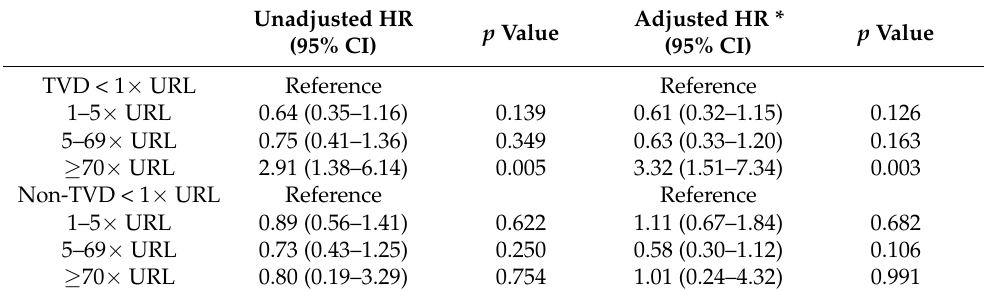
Table 4. Univariate and Multivariate Cox analysis of the predictive value of cTnI for 5-year MACE among TVD and non-TVD